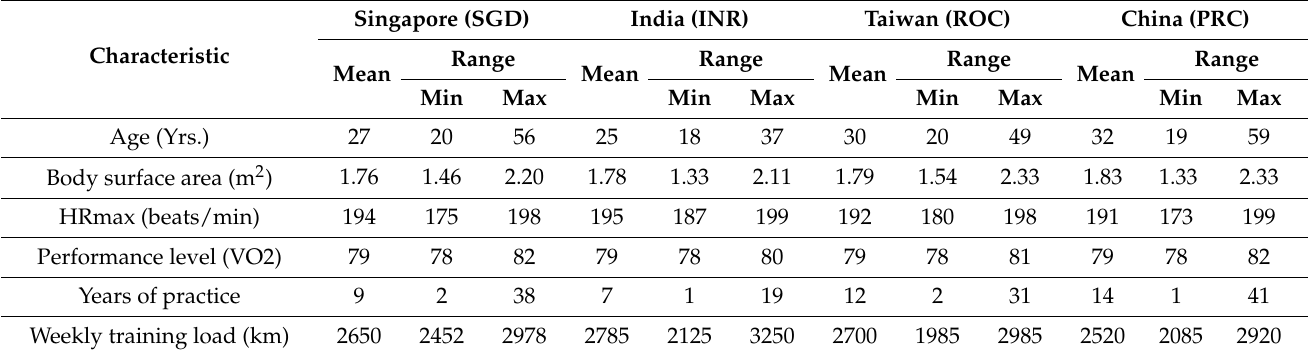
Table A3. Summary of cyclists’ characteristics ( n = 406).